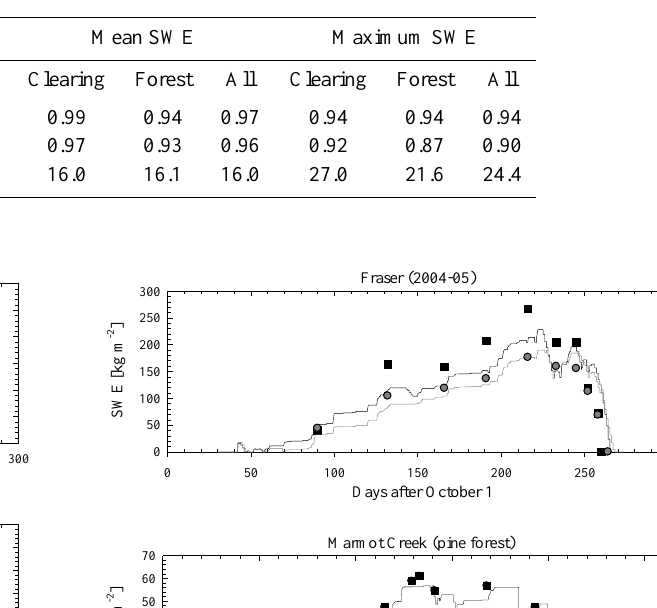
Table 2. Model bias index (MB), model efficiency index (ME), and root mean square error (RMSE) of simulated mean and maximum snow water equivalent (SWE) at clearing sites, forest sites, and all sites.